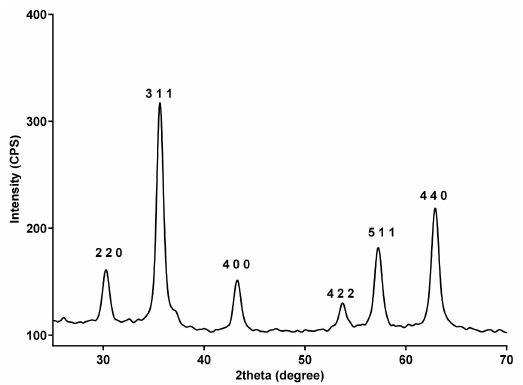
Figure 1. XRD patterns of fabricated Fe 3 O 4 @ β -CD nanopowders.